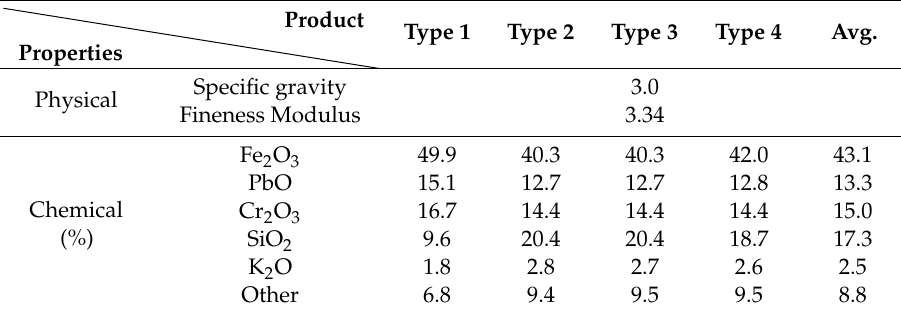
Table 3. Physical and chemical compositions of heavyweight waste